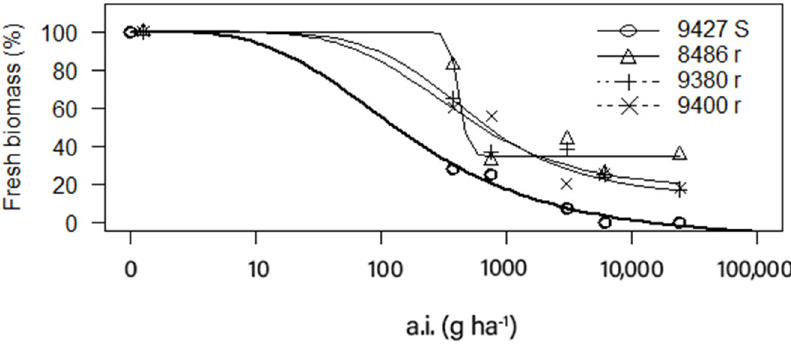
Figure 4. Dose-response curves of Centaurea cyanus populations with reduced susceptibility (r) and susceptible (S) to 2,4-D.